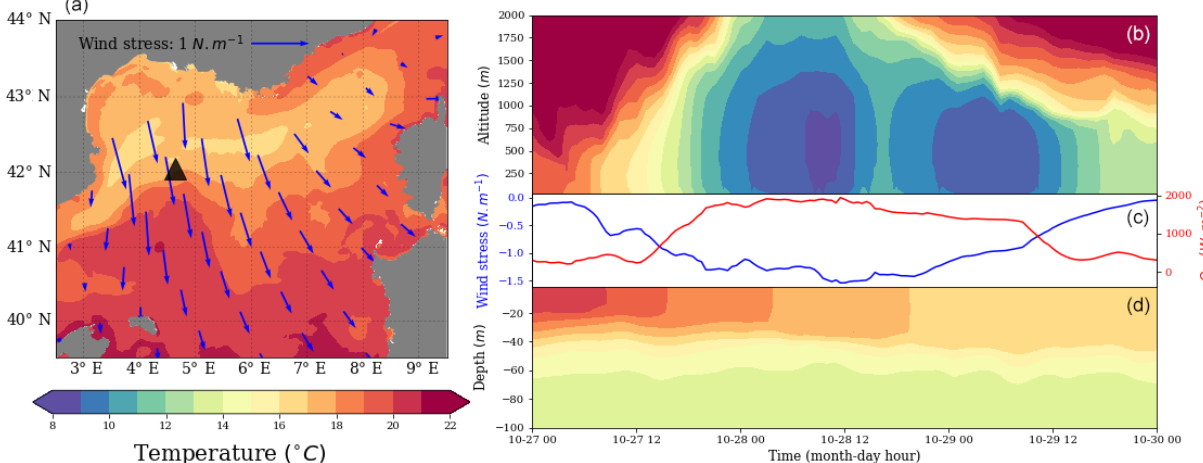
Figure 10. Results from the coupling between Meso-NH and SYMPHONIE. (a) Sea surface temperature (color, ◦ C) and 10m wind (vector, ms − 1 ) averaged over 27–30 October 2012. The triangle symbol shows the location of the LION buoy. (b) Time evolution of the (top) air temperature ( ◦ C), (c) wind stress (blue, Nm − 1 ), sensible heat flux (red, Wm − 2 ), and (d) water temperature ( ◦ C) at the LION